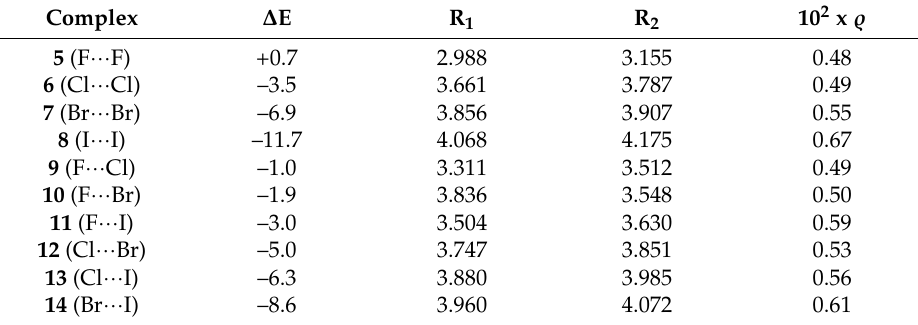
Table 1. Interaction energies ( ∆ E, kcal/mol) and equilibrium distances (R 1 and R 2 , Å), and value of the level of